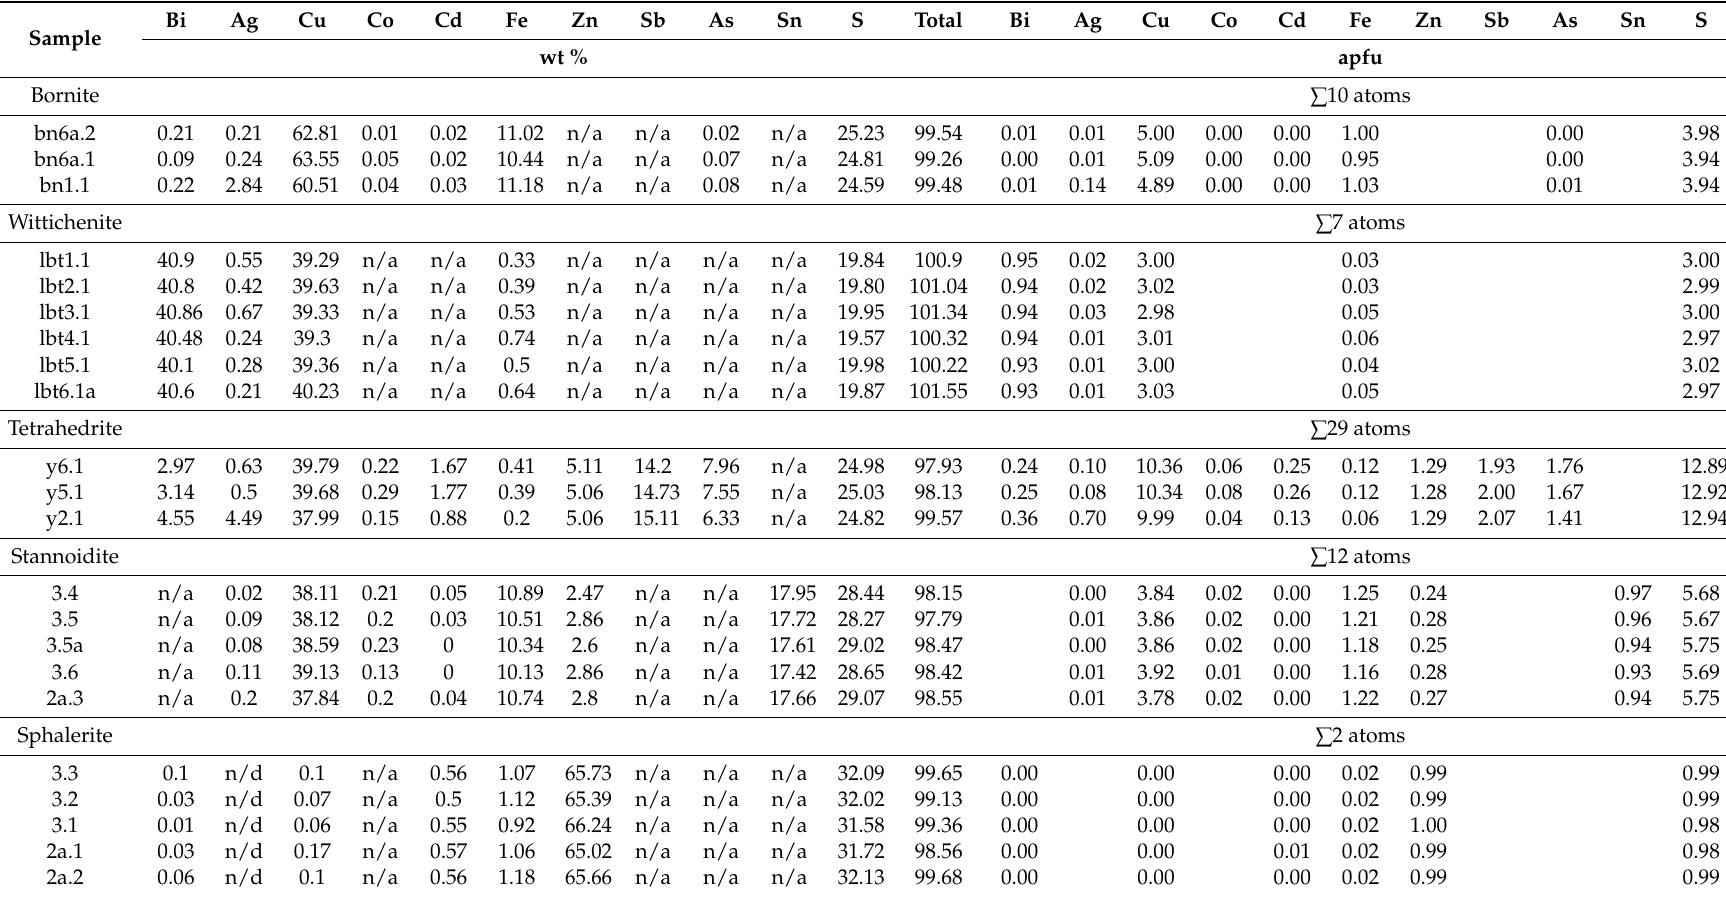
Table 3. Representative EPMA data for bornite, wittichenite, tetrahedrite, stannoidite, and